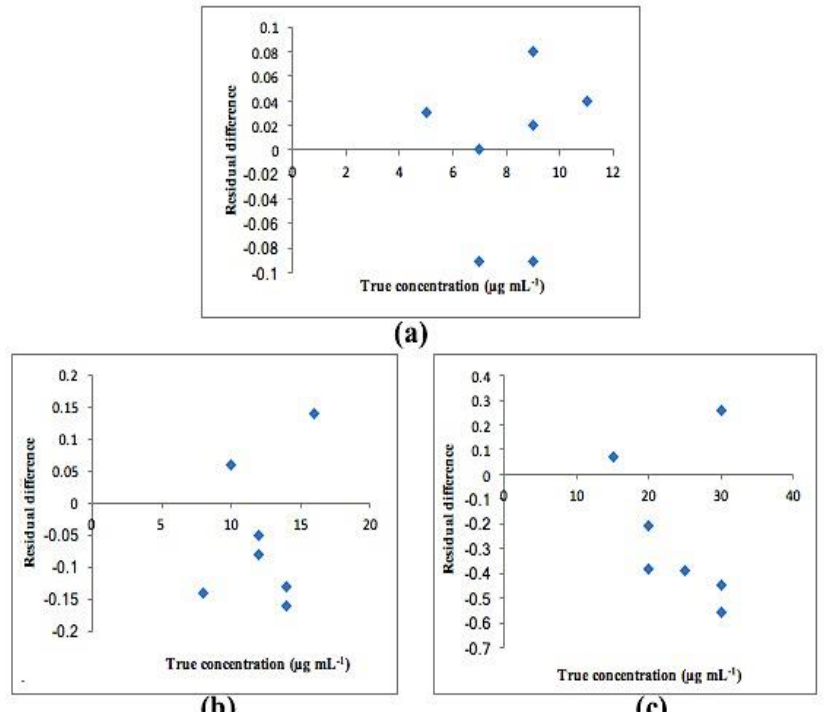
Figure 8. Residual plot of residual difference between true and found concentrations for ( a ) CS, ( b ) Deg1 and ( c ) Deg2 for PLS-2 model. Table 5. Percentage recoveries of CS, Deg1 and Deg2 in the validation set using PCR and PLS-2. PCR PLS-2 Found% Found% Mix. No. CS Deg1 Deg2 CS Deg1 Deg2